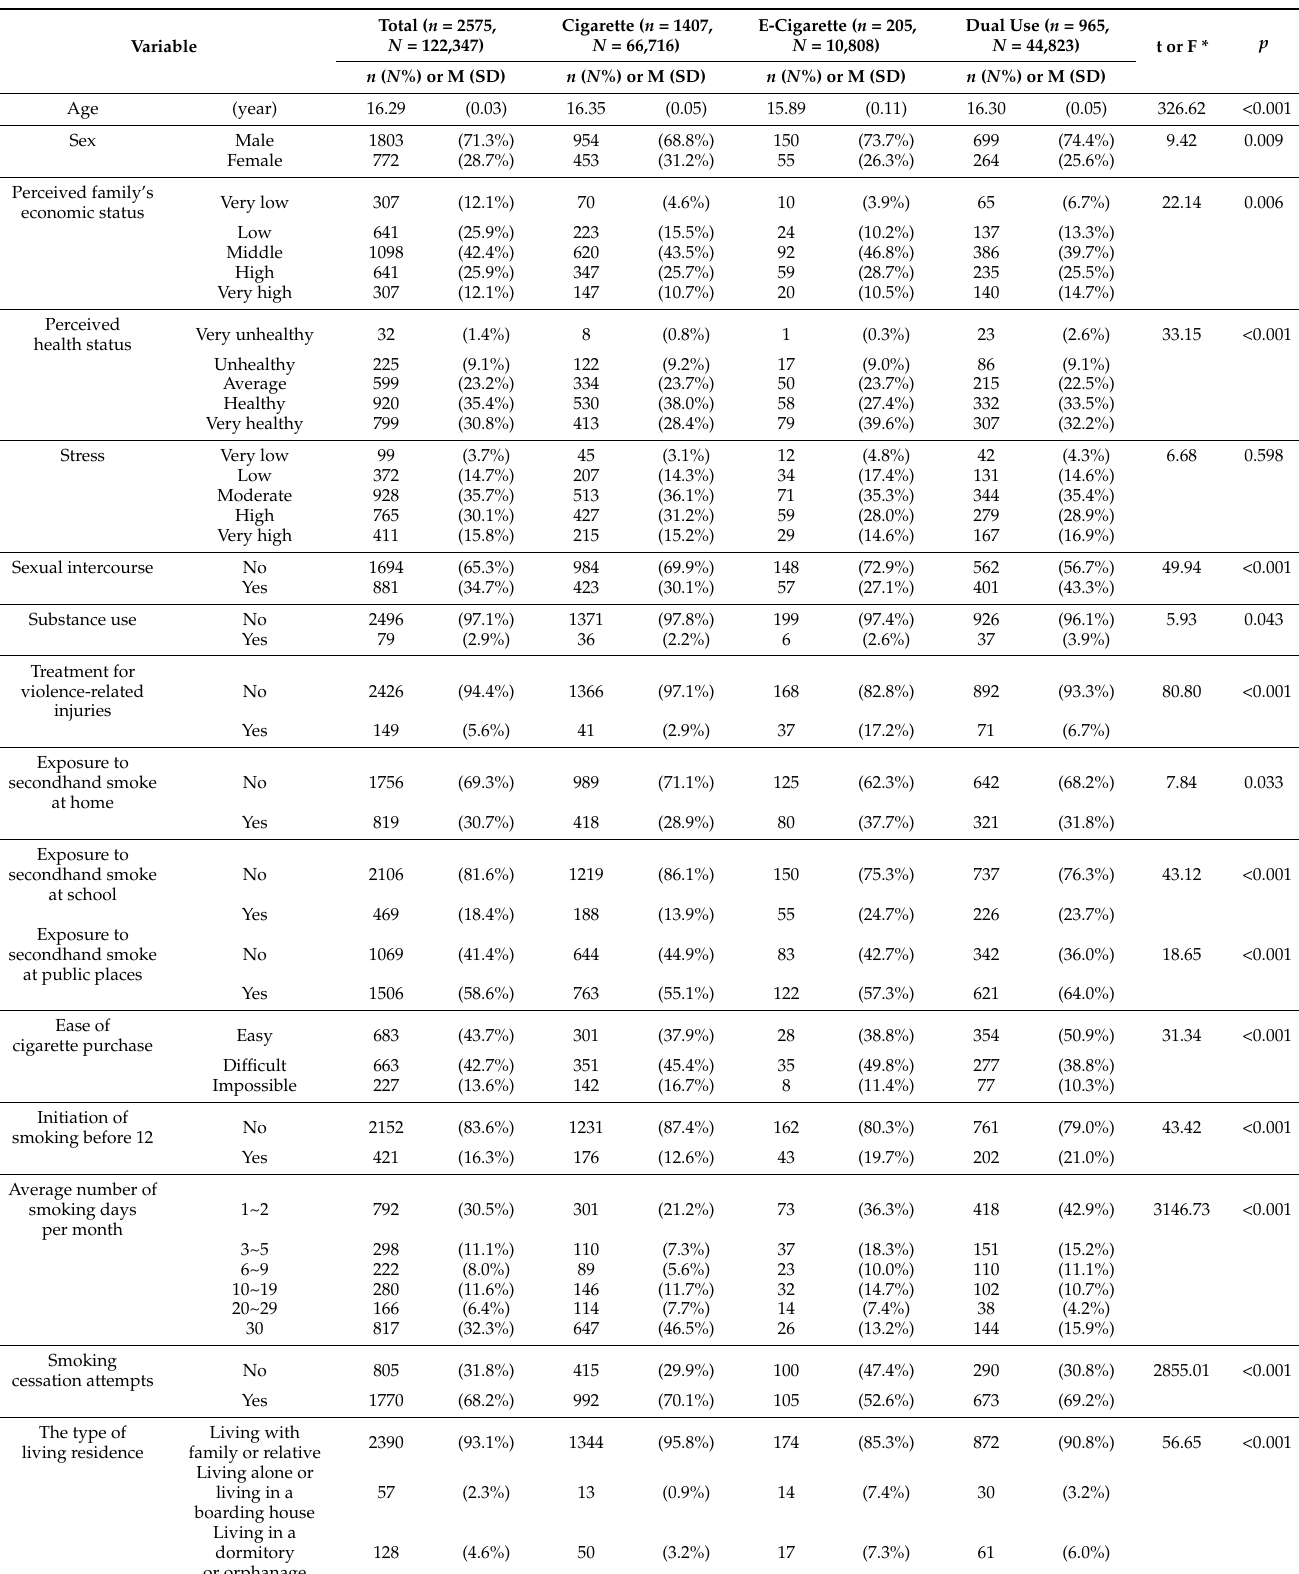
Table 2. Characteristics of participants by tobacco type/form during the COVID-19 pandemic (2020). ( n = 2575, N =